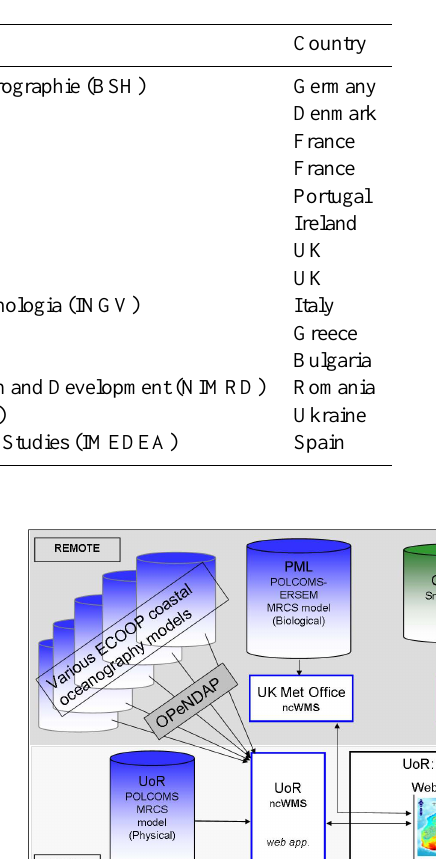
Table 1. Full list of ECOOP partner institutes providing model data to the portal. Numbers match with model areas shown in Fig. 1.